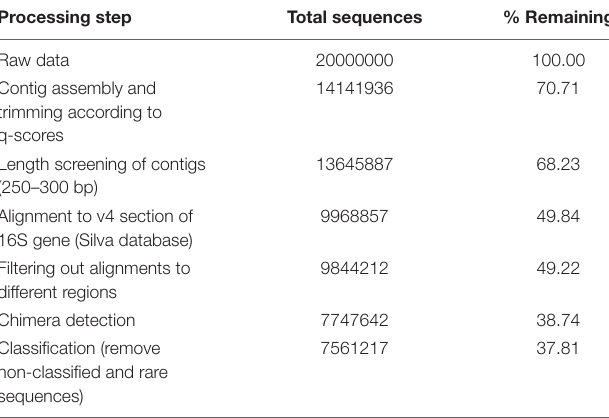
TABLE 2 | Screening steps of 16S sequencing data analysis.